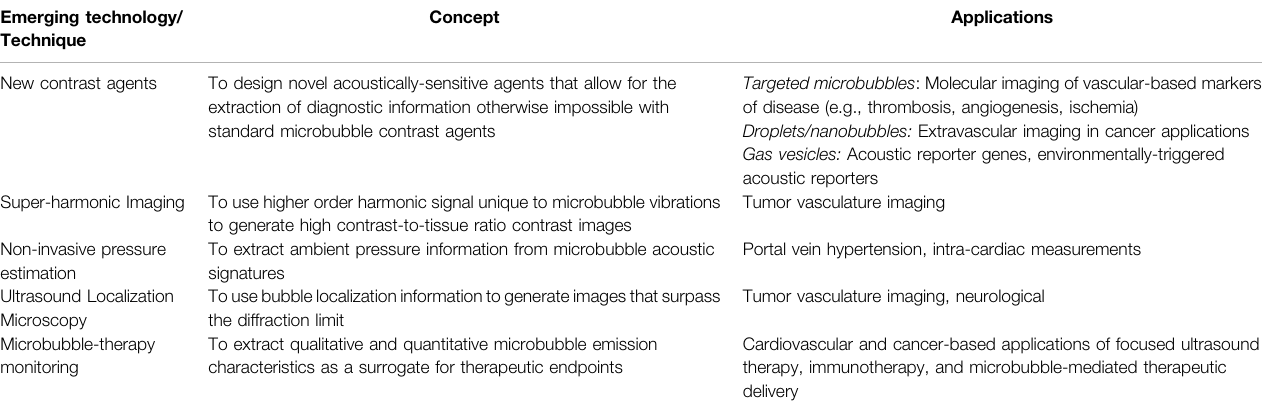
TABLE 2 | Summary of emerging ultrasound-microbubble based techniques. See text for references and further